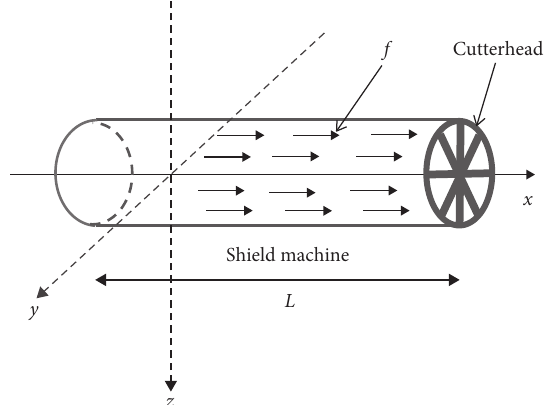
Figure 3: Calculation model of soil deformation caused by uneven lateral